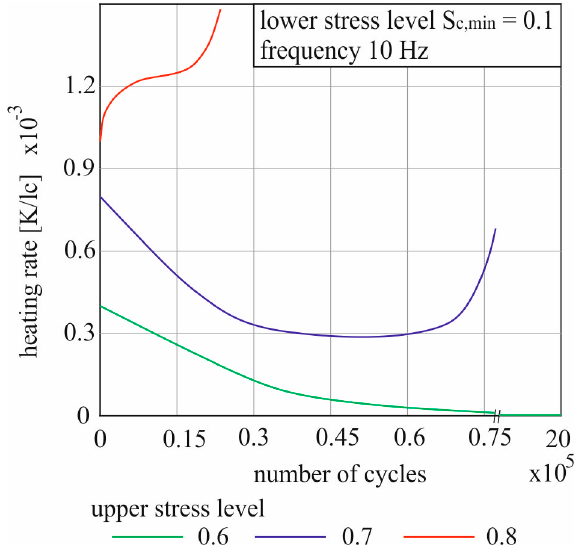
Figure 11. Heating rate of UHPC 1 specimens for test frequency f P = 3 Hz and an upper stress level of S c,max = 0.6, S c,max = 0.7 and S c,max = 0.8.